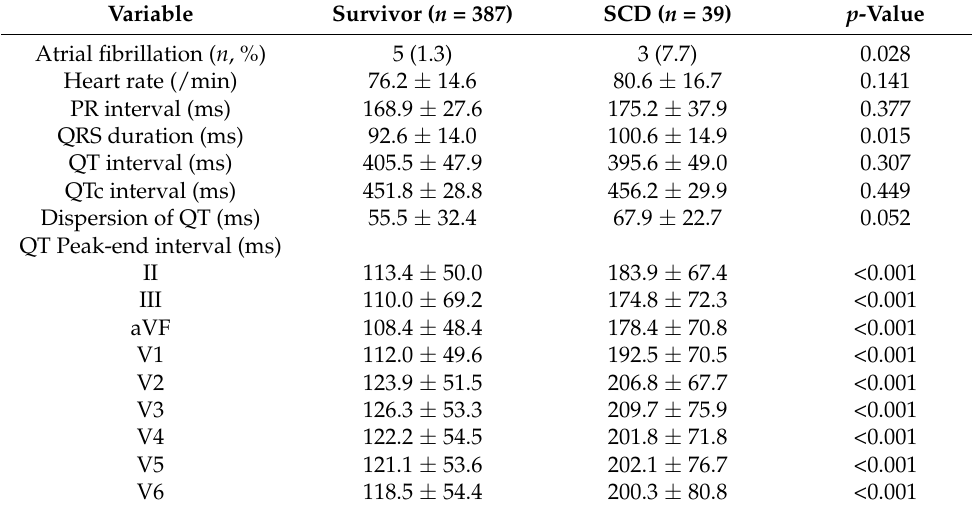
Table 2. Baseline ECG findings before hemodialysis.